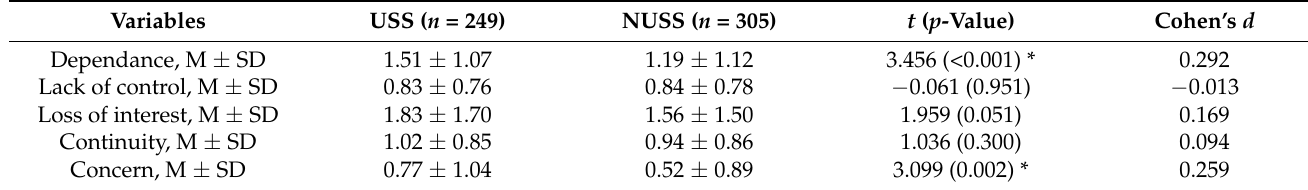
Table 4. Differences between USS and NUSS in exercise